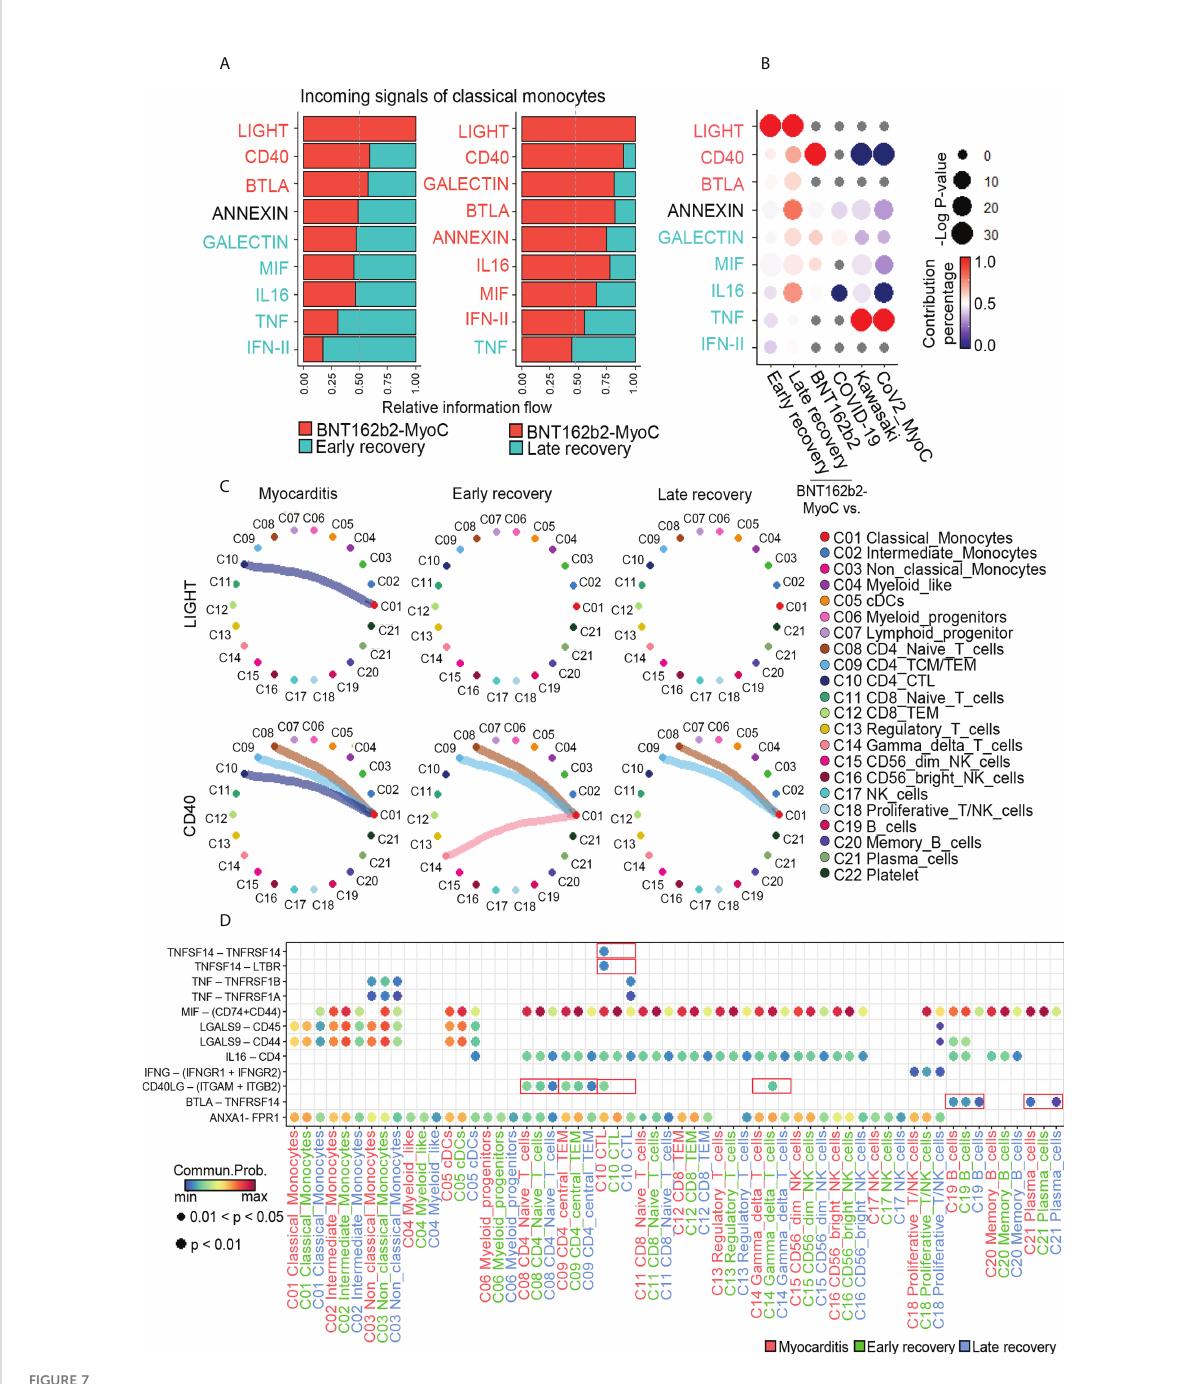
FIGURE 7 Classical Monocytes receives Cytotoxic T cell-mediated Incoming Signals in BNT162b2-myocarditis Stage. (A) Bar graphs showing the ranking of major incoming signals of classical monocytes in the patients in BNT162B2-MyoC stage compared to early(left) and late(right) recovery stages, respectively. The rank of signals was based on differences in overall information fl ow, which is calculated by the total weights in the cellular network, of each group. (B) A dot plot showing signaling enrichment of classical monocytes in other datasets for the classical monocyte- speci fi c incoming signals in BNT162B2-MyoC stage. Grey dots indicate insigni fi cant interactions. (C) Circle plots showing the intercellular network of increased incoming signals of classical monocytes in BNT162B2-MyoC stage. Arrows and edge color indicate direction (source: target). Edge thickness indicates the sum of weight key signals between populations. (D) A dot plot showing the relative signi fi cance of each cell type for each signaling pathway based on the average expression of the ligand-receptor